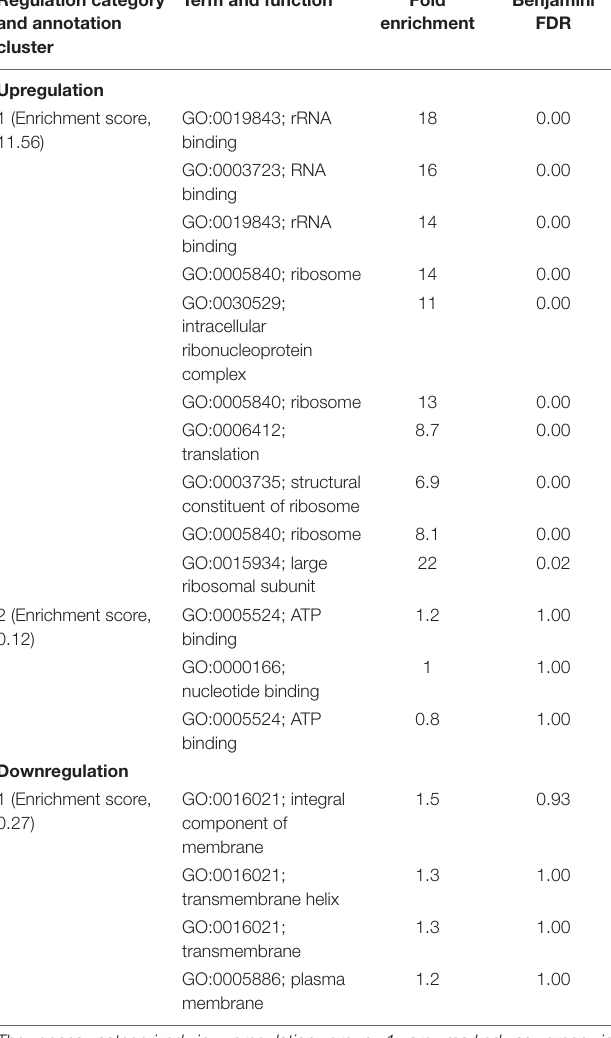
The genes categorized in upregulation group 1 are marked as green in Supplementary Table S4 ; the genes categorized in upregulation group 2 are marked as blue in Supplementary Table S4 ; the genes categorized in downregulation group 1 are marked as red in Supplementary Table S4.